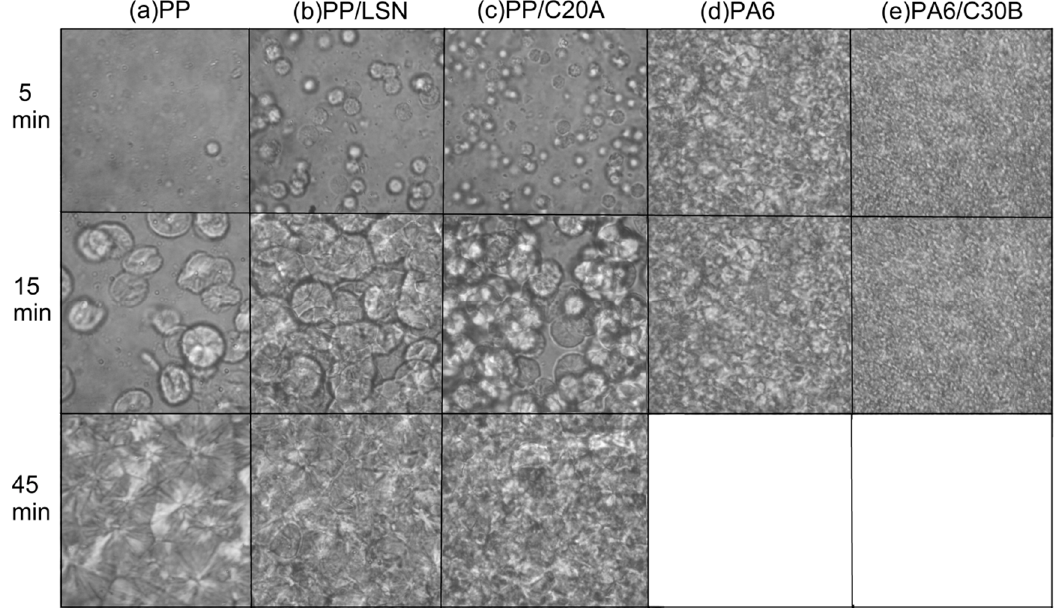
Figure 4. Optical micrographs showing the nucleating effect on the crystallization and the spherulite growth of the nanocomposites with 10 wt % at different times.